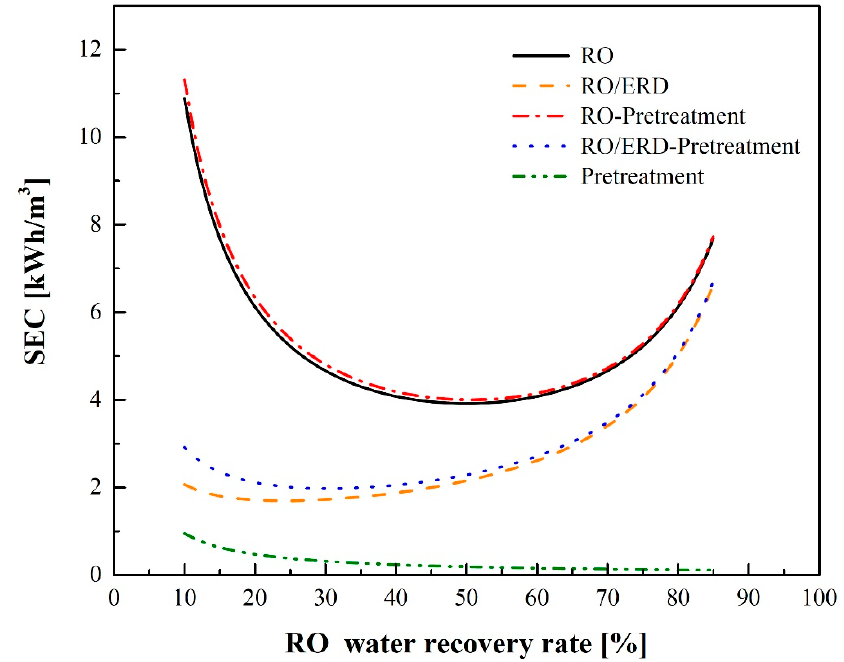
Figure 6. Comparison of SEC between the stand-alone RO and RO-ERD processes simulated with and without pretreatment.